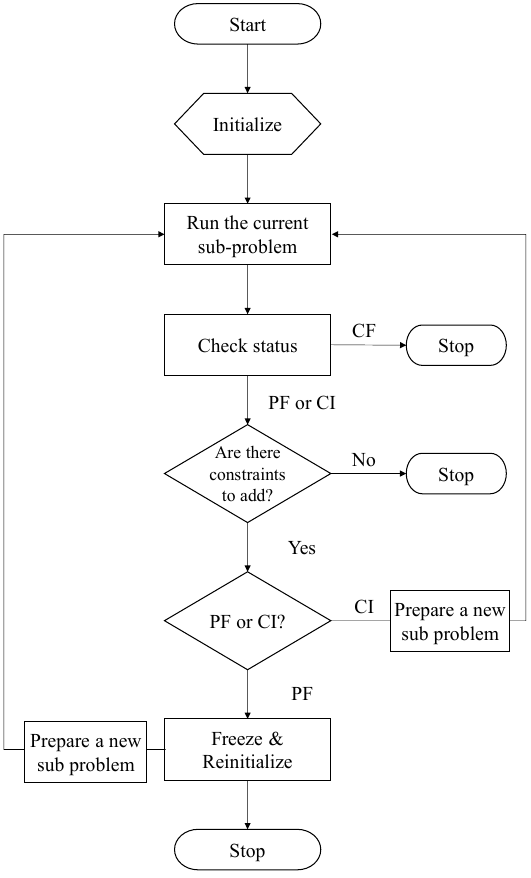
Figure 2. Flow chart of the BF algorithm.